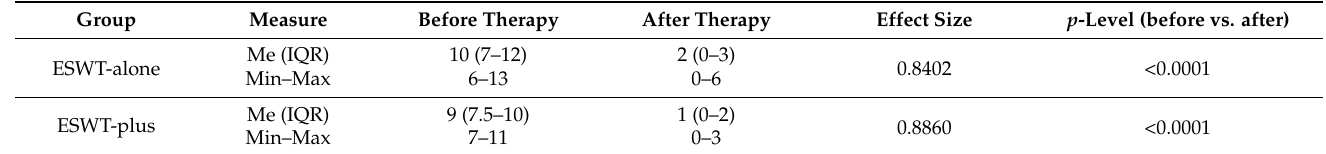
Table 5. Assessment of pain intensity according to the Laitinen scale before and after therapy in the compared groups.